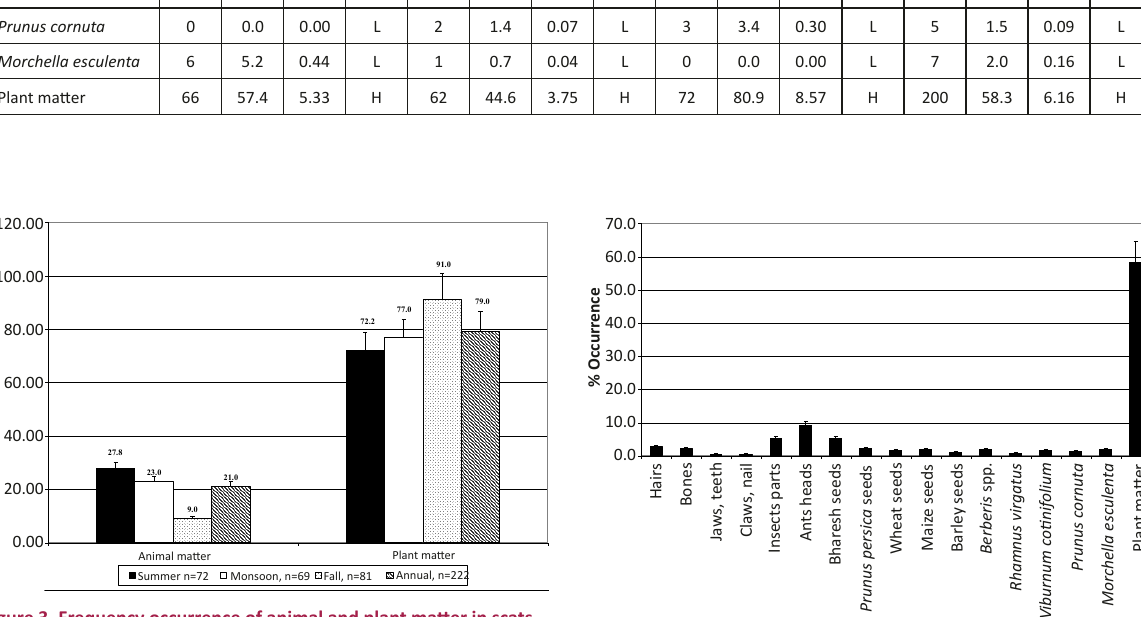
Figure 3. Frequency occurrence of animal and plant matter in scats of the Himalayan Brown Bear in different seasons in Kugti Wildlife Sanctuary during